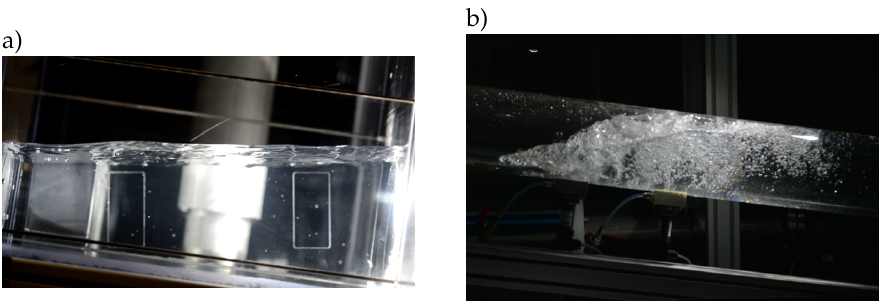
Figure 3. ( a ) Instantaneous picture of the free surface in the reduced scale forebay tank. ( b ) In- stantaneous picture of the free surface in a partially emptied pipe. The flow discharge is set to its maximal